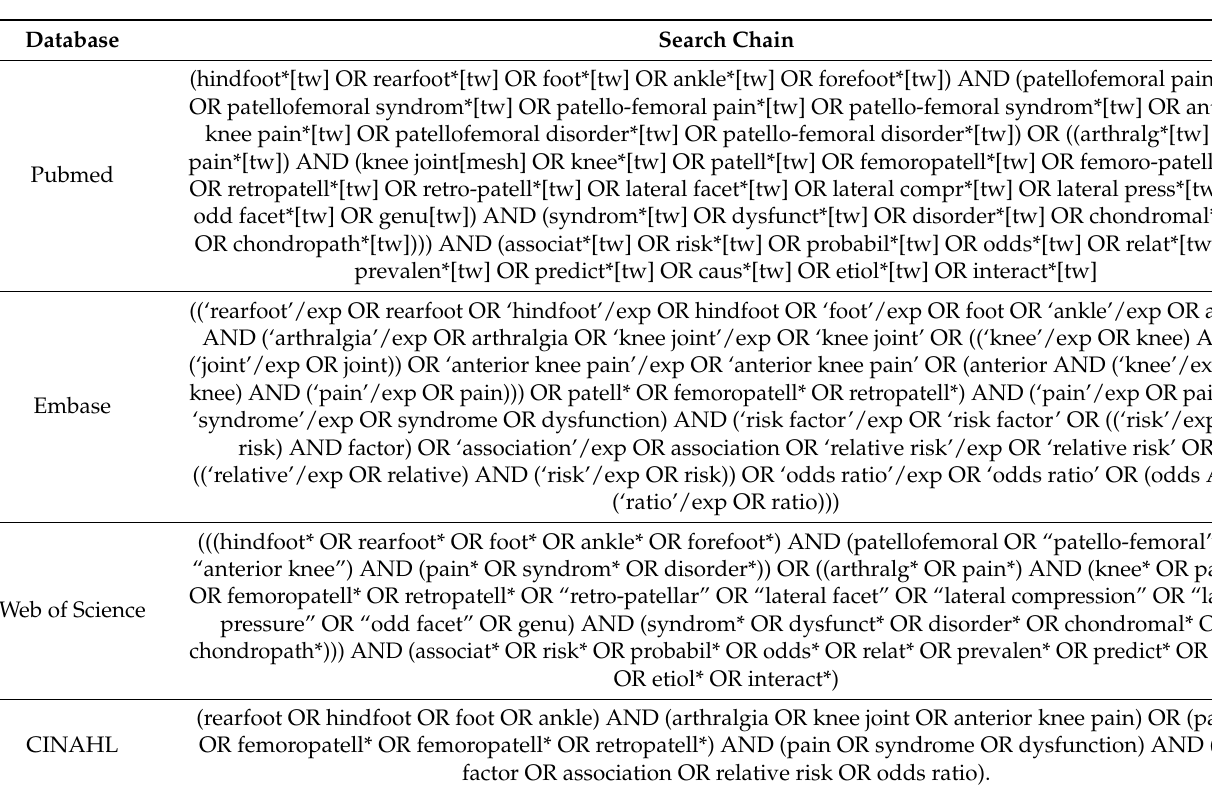
Table A1. Database and search chain